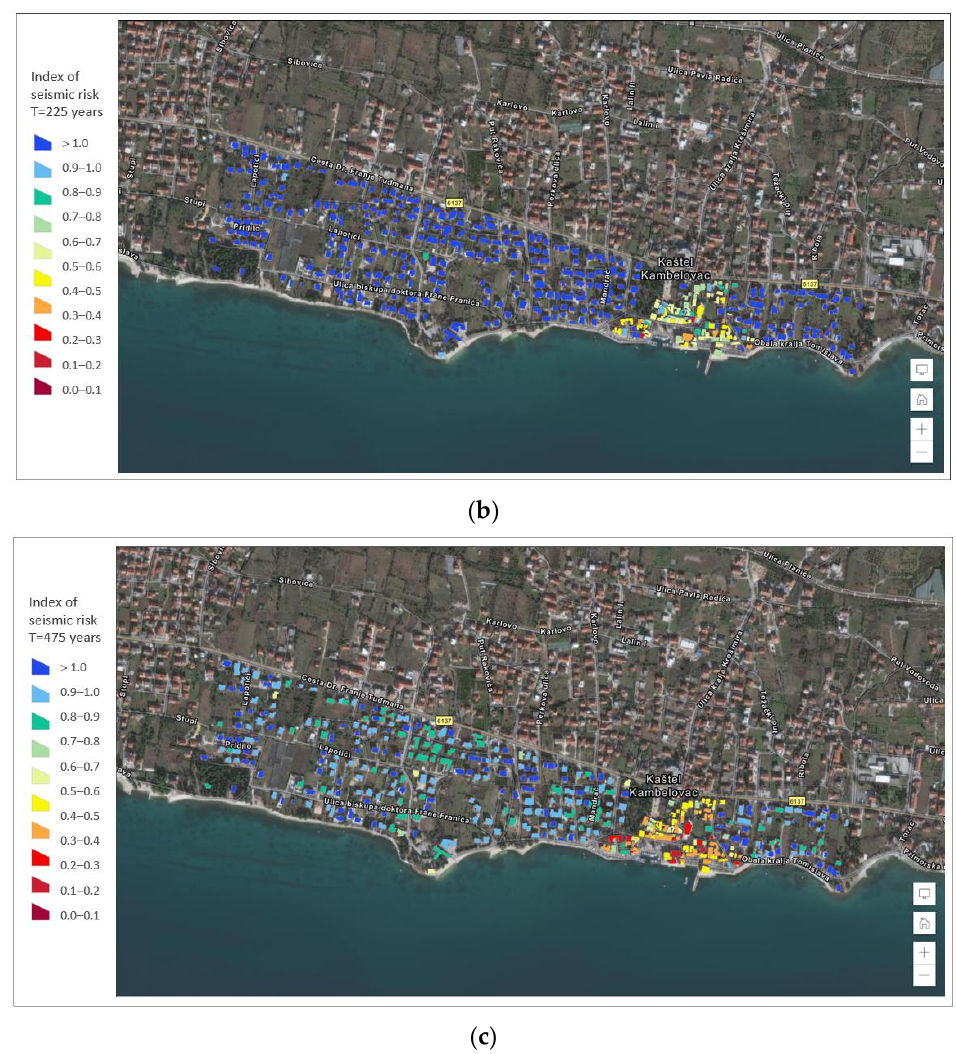
Figure 18. Risk maps in terms of index of seismic risk: ( a ) T = 95 years; ( b ) T = 225 years; ( c ) T = 475 years.